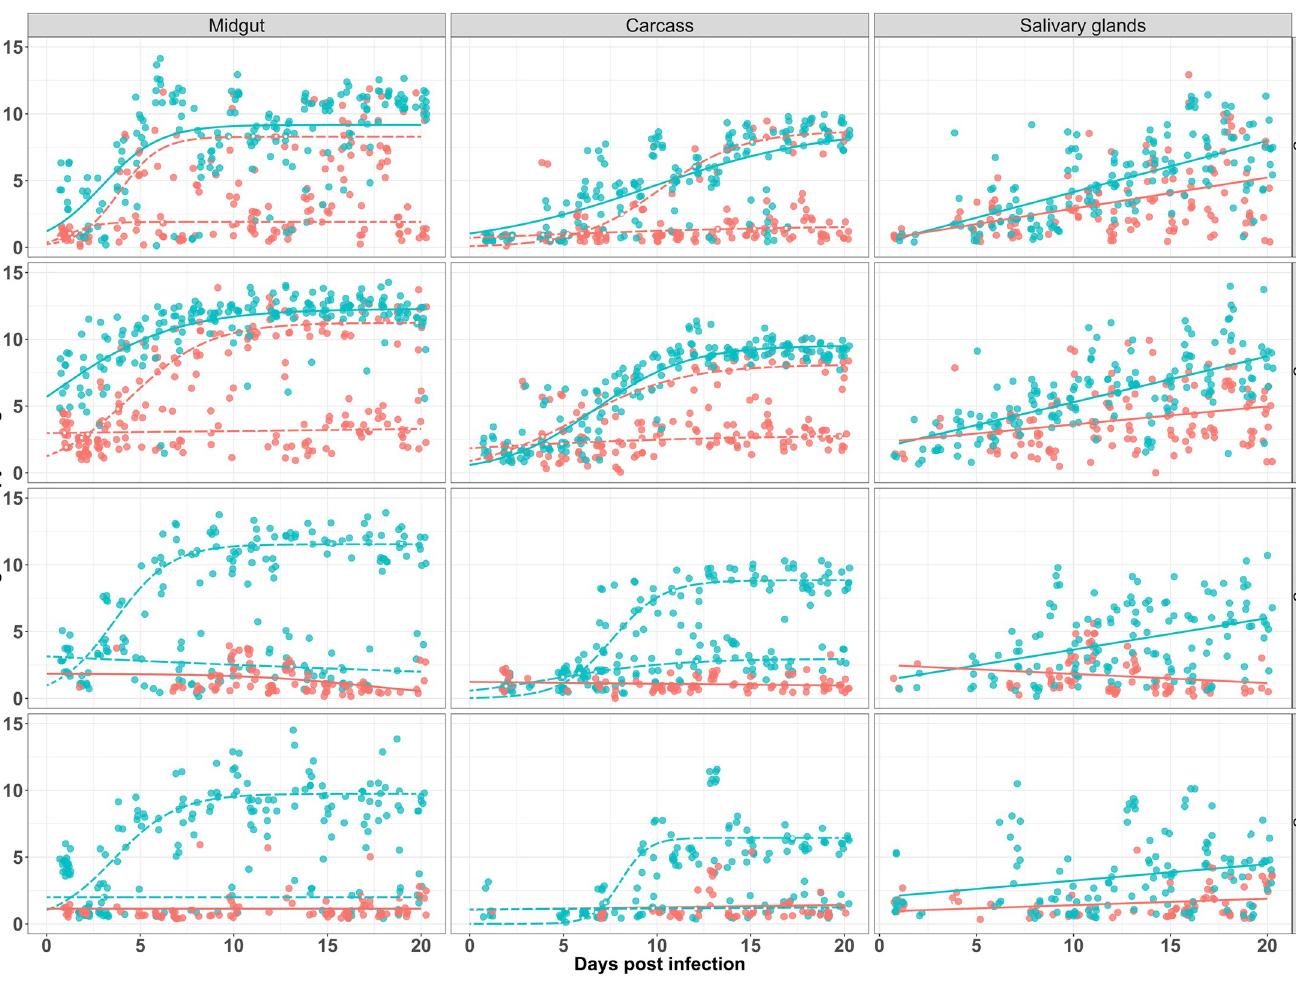
Fig 2. DENV kinetics by strain, tissue and infectious dose. For the midgut and carcass, lines represent the fitted parametric growth curves for DENV loads. Growth curves were fitted on logarithmic transformed data. For the salivary glands, lines represent a linear regression for DENV load. Linear regressions were fitted on logarithmic transformed data. For all tissues and serotypes, points represent individual mosquito values (n = 10); in red, low infectious dose (10 5 DENV copies/ml); in blue, high infectious dose (10 8 DENV copies/ml). Points for the subpopulations have been “jittered” to avoid overlap. Dashed lines represent subpopulations.